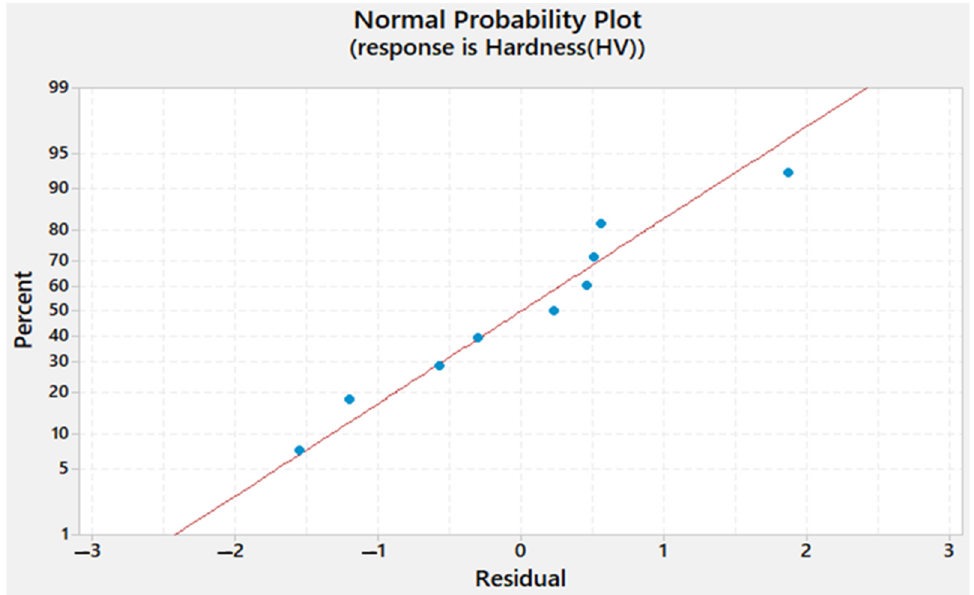
Figure 15. Normal probability plot of the residuals for the hardness.